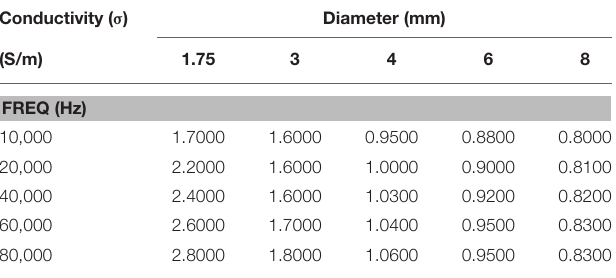
TABLE 1 | Calculated ideal conductivity of 0.45% saline solution for various phantom diameters as function of frequency at room temperature for 5-5-5-guidewire.